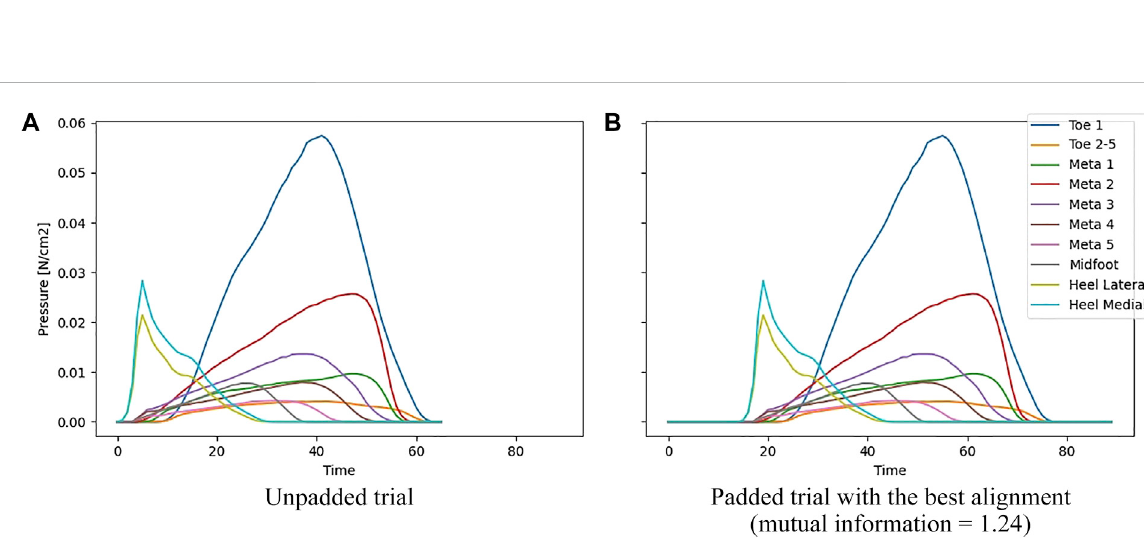
FIGURE 2 a)Unpaddedtrial.b)Paddedtrialwiththebestalignment(mutualinformation=1.24). (A) showsanunpaddedtrial, (B) showsthepaddedtrialthat is optimally aligned (it has the highest 2D histogram-based mutual information) w.r.t. its